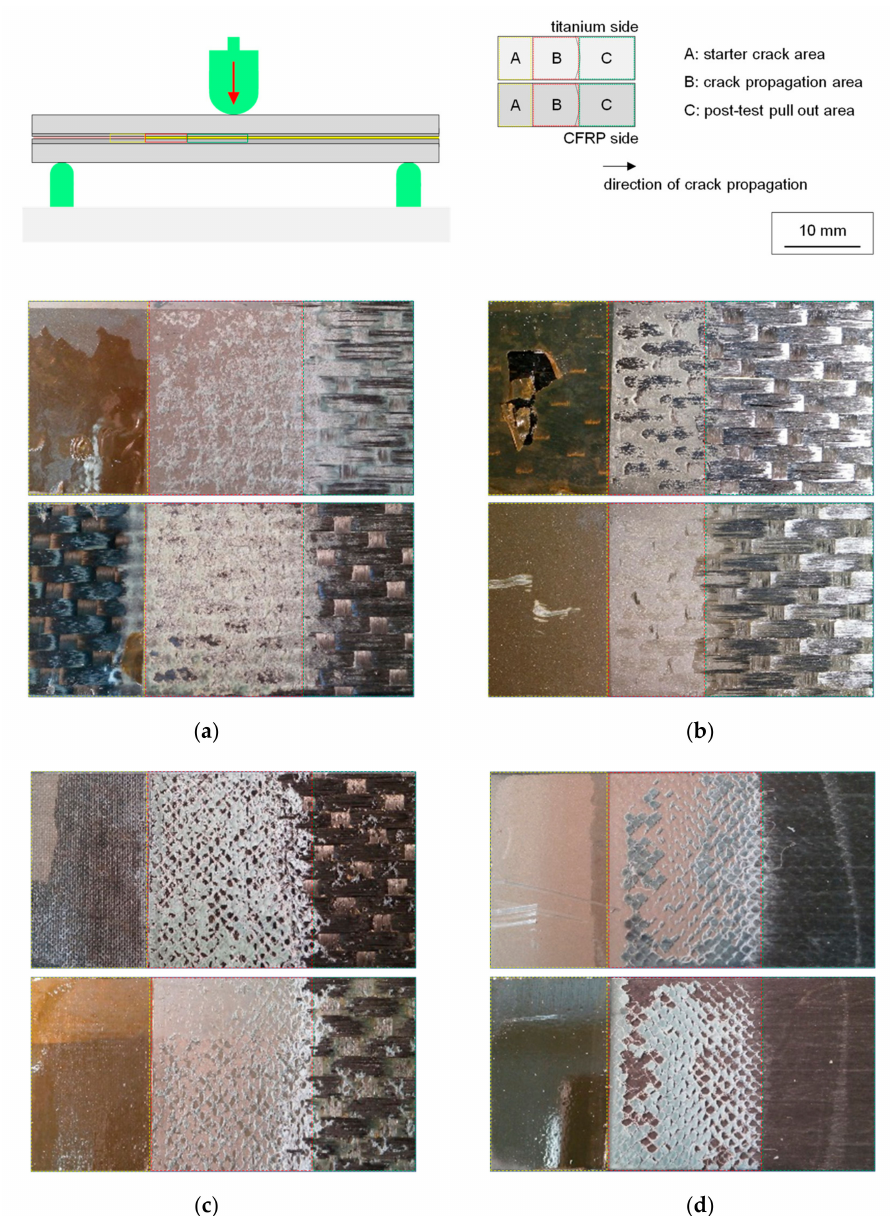
Figure 9. Fracture surfaces of a representative end-notched flexure (ENF) specimen from each of the four manufacturing options (MOs) studied: ( a ) MO 1, ( b ) MO 2, ( c ) MO 3, and ( d ) MO